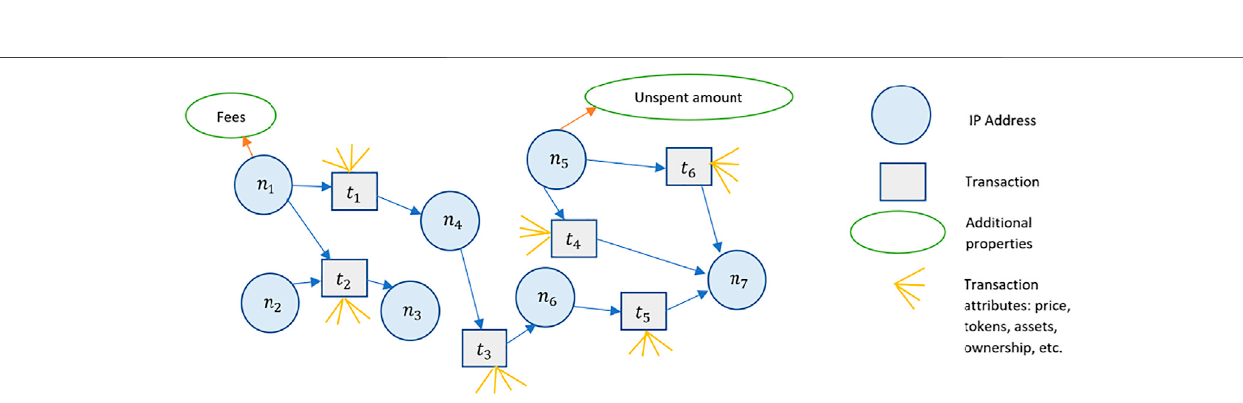
Frontiers in Robotics and AI |